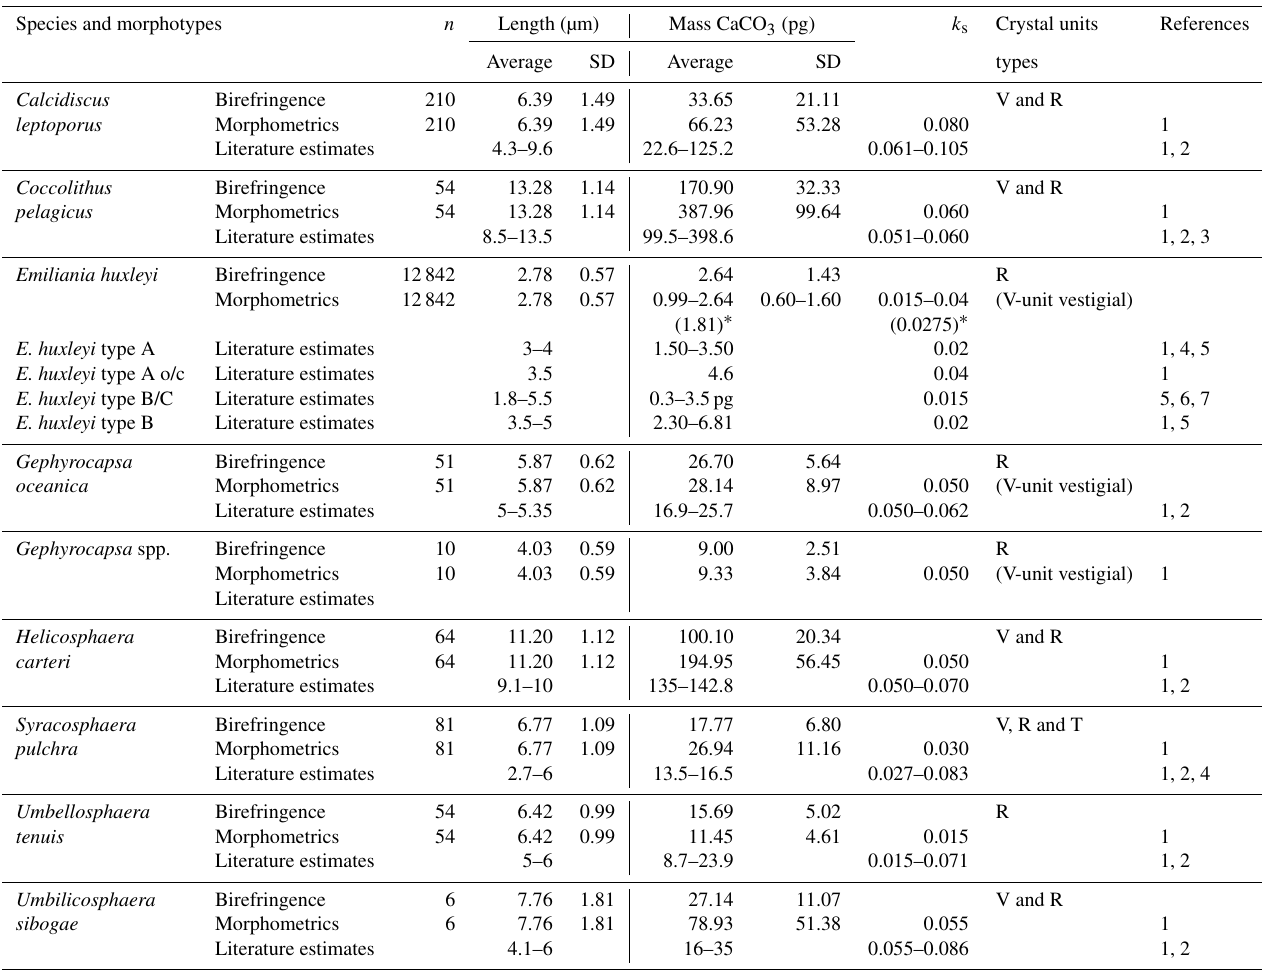
Table 1. Coccolith mass estimates of the main coccolithophore species found at the SOTS and SAM sites using birefringence (C-Calcita) and morphometrics. Additionally, length and mass estimates from the literature are also listed for most species. References: (1) Young and Ziveri (2000), (2) Beaufort and Heussner (1999), (3) Samtleben and Bickert (1990), (4) Poulton et al. (2010), (5) Poulton et al. (2011), (6) Holligan et al. (2010) and (7) Charalampopoulou et al. (2016). ∗ Coccolith mass range obtained applying the minimum and maximum k s values for E. huxleyi found in the literature (i.e. 0.015 and 0.04,